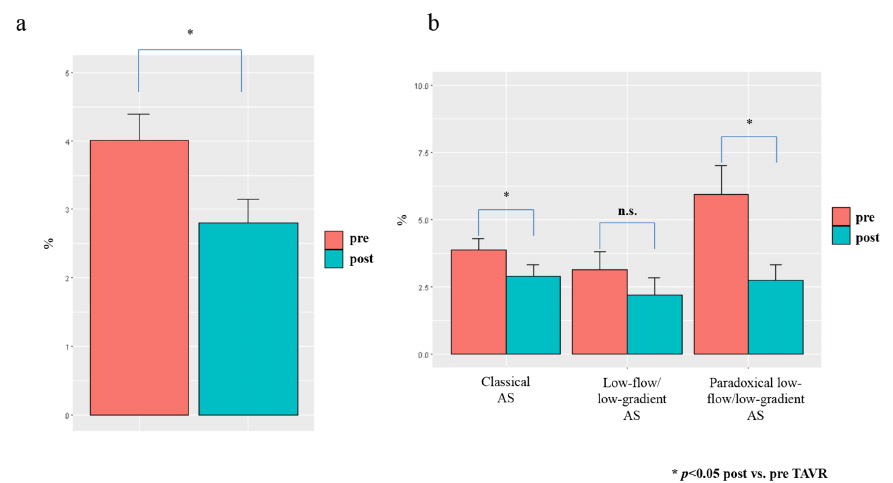
Fig 1. Decreaseof intermediate monocytes after TAVR. Monocytes measured4–7 days after TAVR- procedure by flow cytometry, (a) regardingall patients and (b) split up for different AS entities.